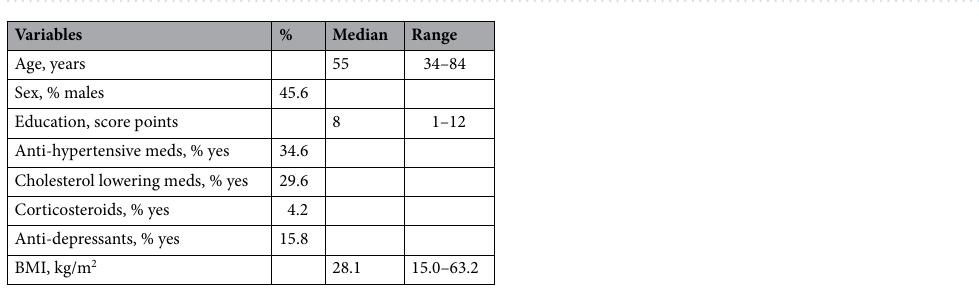
Table 1. Descriptive statistics for study variables in participants from MIDUS (n = 967).